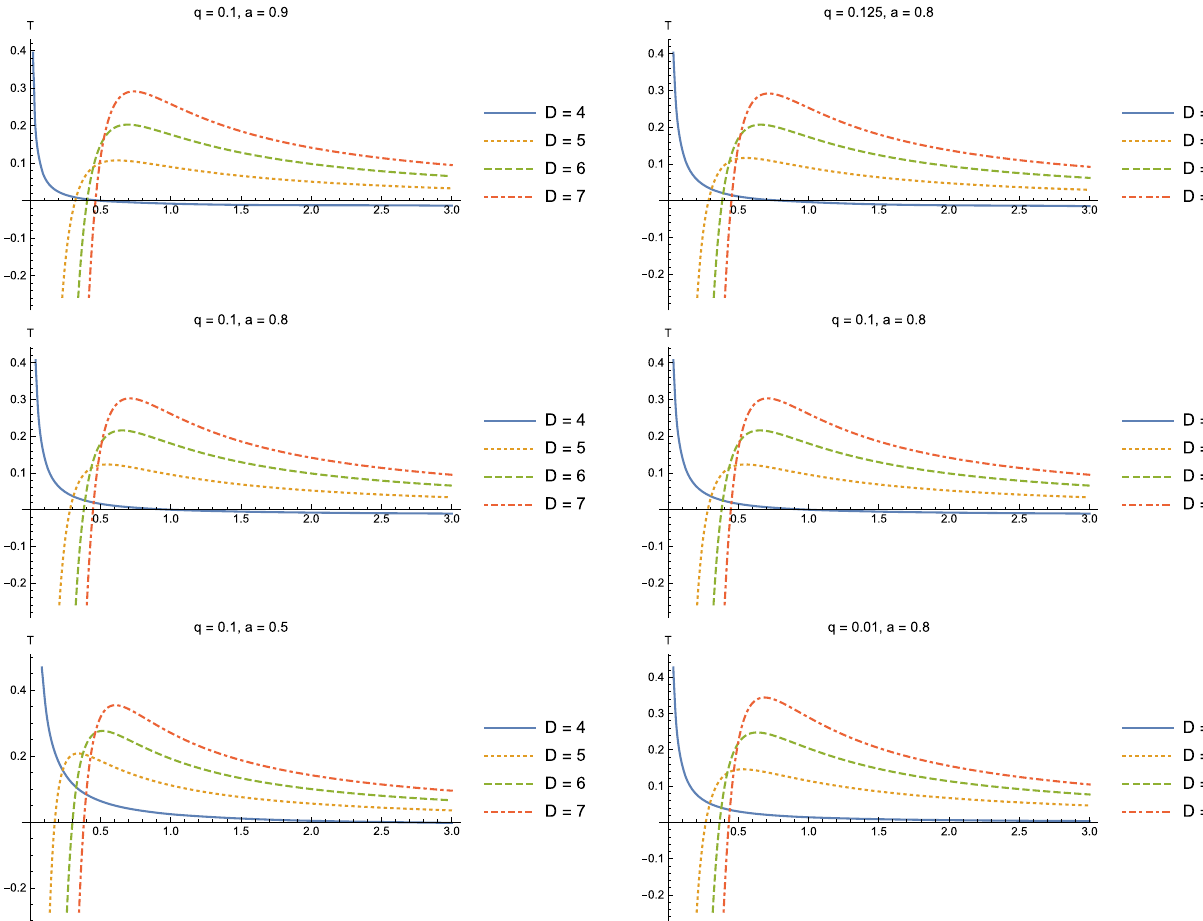
Fig. 8 The Hawking temperature in D-dimensional TGR as function of r h for different values of